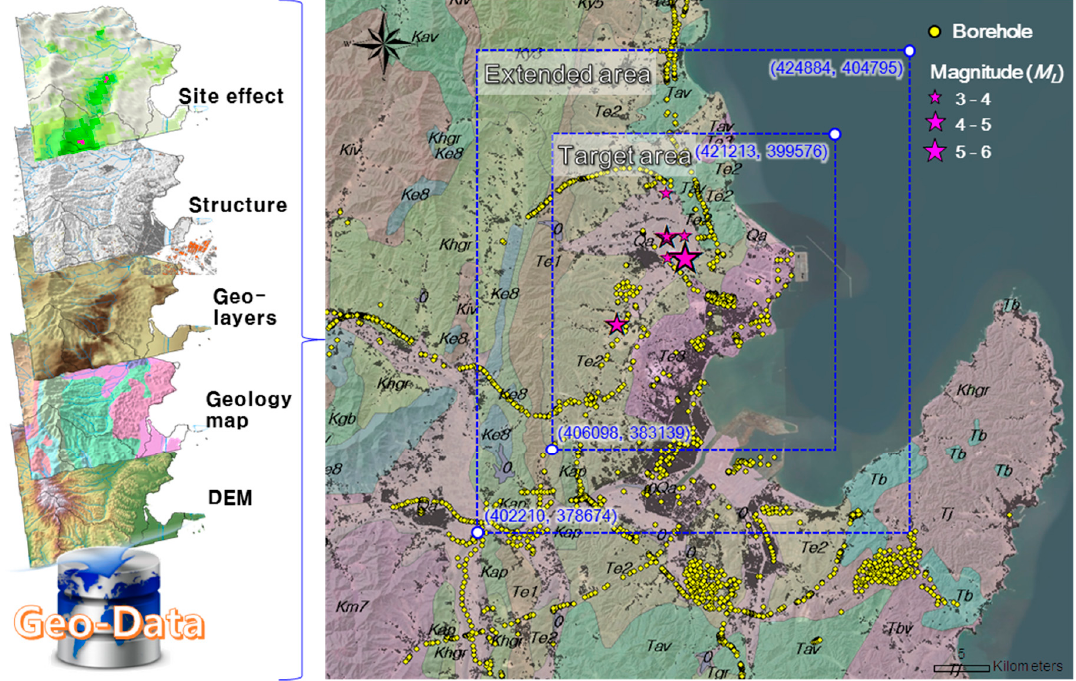
Figure 3. Extended and target areas for spatial modeling of geo-data in Pohang.